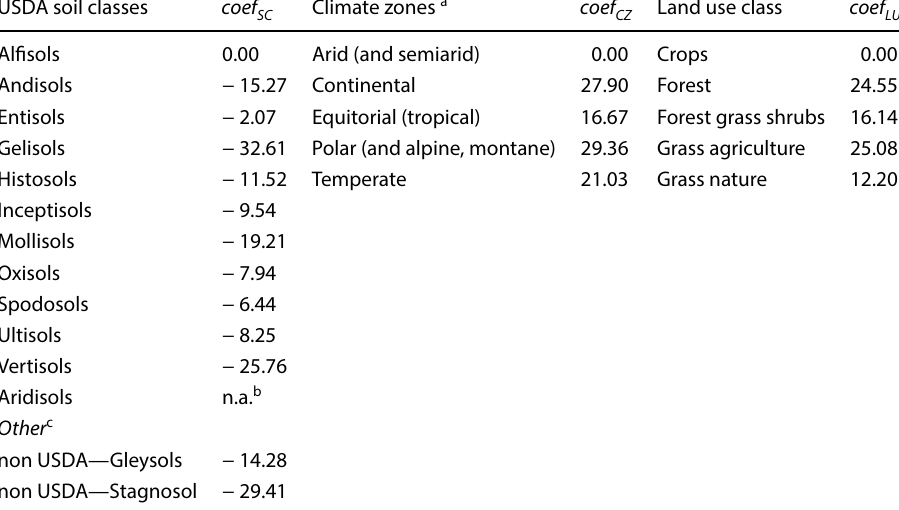
Table 3 Regression coefficients for the topsoil model in equation